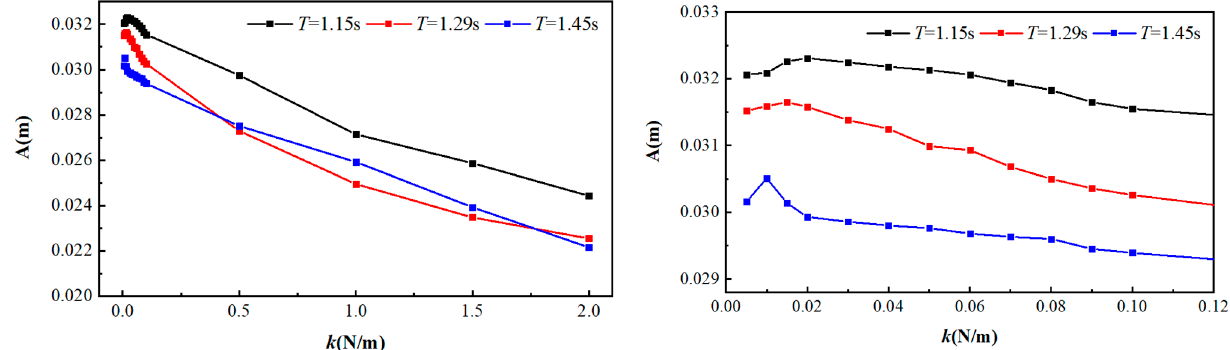
Figure 9. Vibration responses under different wave periods ( U r = 3.36, S/D = 0, A W = 0.0375 m).